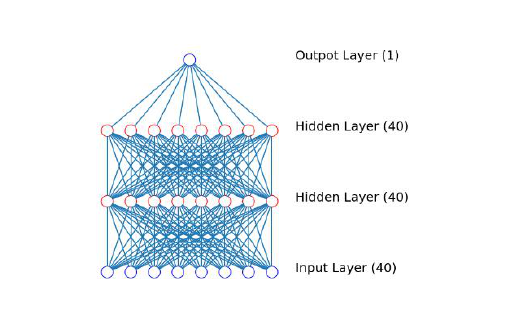
Figure 5. Architecture Perceptron